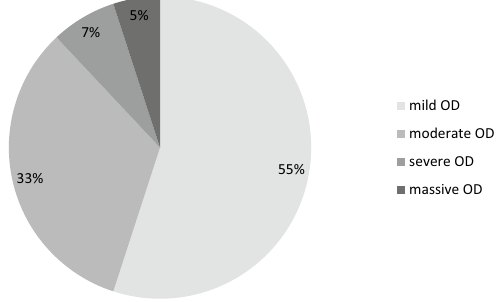
Figure 2. Prevalence by graduation of OD in patients with CNS disease.